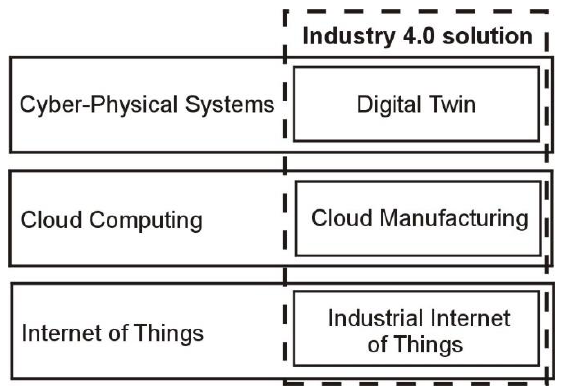
Figure 1. General scheme of Industry 4.0